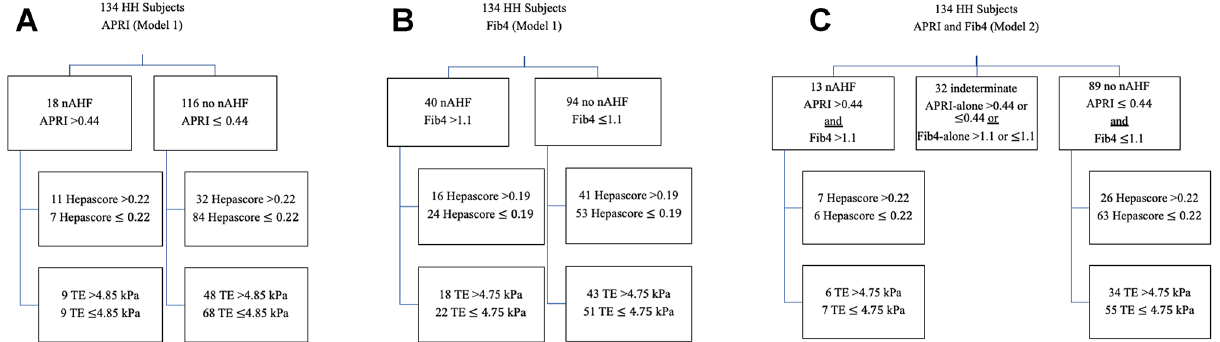
Figure 1. ( A ) Study subjects classified as having noninvasive biomarker detected advanced hepatic fibrosis (nAHF) on the basis of APRI > 0.44 (Model 1). Subjects with APRI ≤ 0.44 were classified as not having nAHF (no nAHF). The numbers of subjects in each of these categories detected by Hepascore (cut-off 0.22) or transient elastrography (TE, cut-off 4.85 kPa) are shown in each box. ( B ) Study subjects classified as having noninvasive biomarker detected advanced hepatic fibrosis (nAHF) on the basis of Fib4 > 1.1 (Model 1). Subjects with Fib4 ≤ 1.1 were classified as not having nAHF (no nAHF). The numbers of subjects in each of these categories detected by Hepascore (cut-off 0.19) or transient elastrography (TE, cut-off 4.75 kPa) are shown in each box. ( C ) Study subjects classified as having noninvasive biomarker detected advanced hepatic fibrosis (nAHF) on the basis of APRI > 0.44 and Fib4 > 1.1. Subjects with APRI ≤ 0.44 and Fib4 ≤ 1.1 were classified as not having nAHF (no nAHF). Those subjects not meeting any of the preceding criteria were classified as indeterminate. The numbers of subjects in each of the nAHF or no nAHF categories detected by Hepascore (cut-off 0.22) or transient elastrography (TE, cut-off 4.75 kPa) are shown in each positive, P < 0.001, Chi-square). Subjects with nAHF classified using Fib4 had significantly higher age, serum ferritin, and AST levels compared with those who did not have nAHF (Table 2). Eight of 40 subjects with Fib4- determined nAHF had serum ferritin values > 1000 µg/L; 6 of these were detected with Hepascore > 0.19 and 5 with TE > 4.75 kPa. Overall for Model 1, Hepascore demonstrated limited diagnostic utility using a cut-off value of 0.22 for detecting AHF in comparison with APRI. Hepascore was not diagnostically useful for detection of AHF in comparison with Fib4. TE was not diagnostic in comparison with either APRI or Fib4. Both Hepascore and TE detected significantly lower numbers of true positive or true negative cases compared with APRI or Fib4, except in subjects with serum ferritin levels > 1000 µg/L. Model 2—performance of Hepascore and TE in comparison with combined APRI and Fib4. Thirteen of 134 subjects (10%) had both an elevated APRI and Fib4 and were defined by this model as having nAHF (Fig. 1C). Eighty-nine subjects (66%) had APRI and Fib4 values below the cut-off levels and were defined as not having nAHF (no nAHF), whilst 32 (24%) were indeterminate. The AUROC curve analysis for the diagnosis of nAHF demonstrated that Hepascore had an AUROC of 0.70 (95% CI 0.54–0.86, P = 0.02), and a maximum sensitivity and specificity of 64% and 67%, respectively, at a cut-off value of 0.22 (Fig. 3A). TE had an AUROC of 0.52 (95% CI 0.31–0.72, P = 0.85), and a maximum sensitivity and specificity of 49% and 50%, respec- tively, at a cut-off value of 4.75 kPa (Fig. 3B). Seven of 13 nAHF subjects (54% true positive, 46% false negative) were detected using Hepascore > 0.22 (P < 0.01, Chi-square) whilst 6 of 13 nAHF subjects (46% true positive,